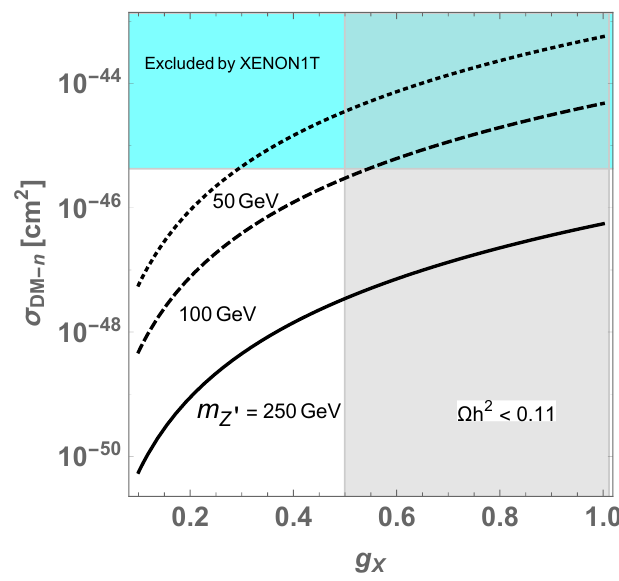
Figure 14 . DM-neutron scattering cross section as a function of g X for m Z 0 = 50 , 100 , and 250 GeV. The gray region is excluded by Ω h 2 . 0 . 11 and the light blue region is excluded by XENON1T, assuming m = 500 N